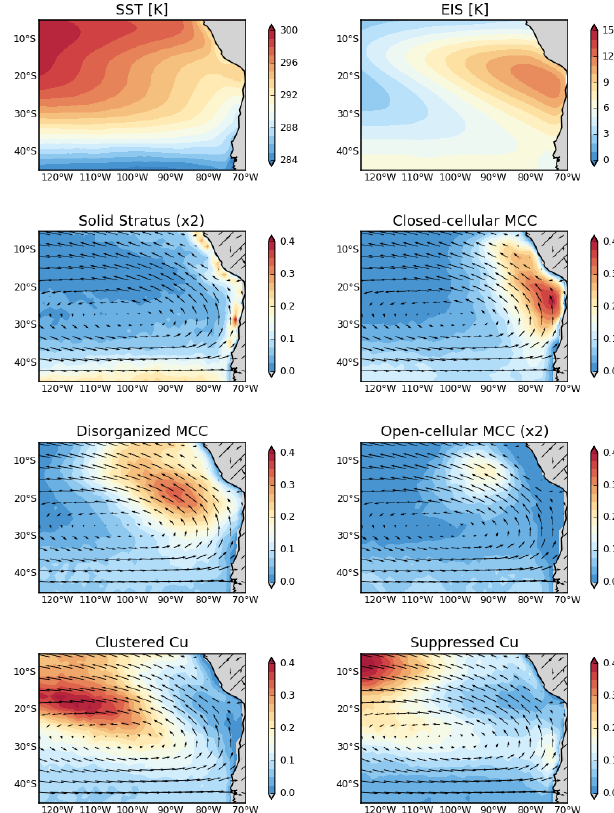
Figure 9. Frequency distributions of various morphology types ob- tained from the classification algorithm in the subtropical east- ern Pacific off the coast of South America for the period 2003– 2018. The top two panels show the SST and EIS climatology from MERRA-2 for the same period. Note the doubling of scale on the stratus and open-cellular